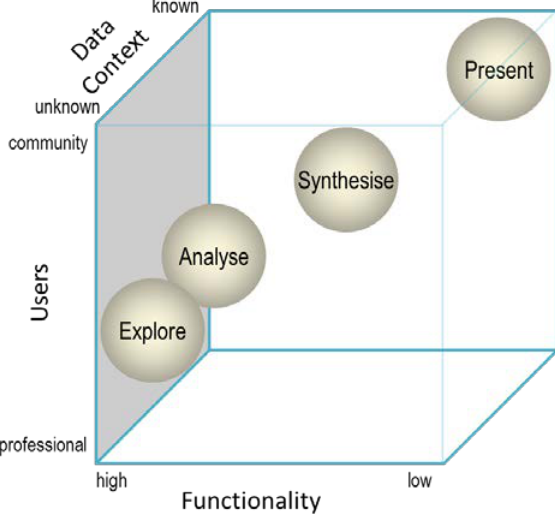
Figure 3: Web map use cube (Adapted from MacEachren & Kraak,